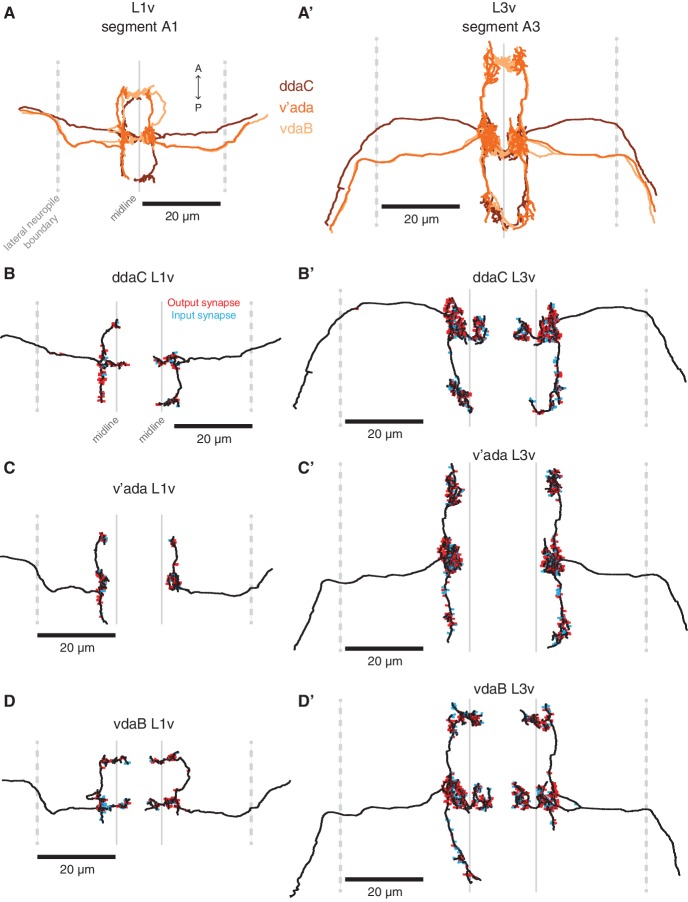
Reconstructions of mdIV terminals.(A, A’), Dorsal view of all mdIV terminals from the L1v (A) and L3v (A’), identities as labeled. Views are at the same scale. Dashed lines indicate lateral neuropil boundaries, solid line the midline. (B, B’) ddaC terminals in the L1v (B) and L3v (B’), left and right shown separately for clarity, as in all subsequent panels. ddaC can be distinguished by a midline crossing where the axon initially approaches the midline from the nerve and a projection into the adjacent segment posterior with little to no midline crossing. (C, C’), v’ada terminals in the L1v (C) and L3v (C’) can be distinguished by a lack of midline crossings and a projection into the adjacent segments anterior and, typically, posterior. D, D’, vdaB terminals in the L1v (D) and L3v (D’) can be distinguished by a midline crossing both where the axon initially approaches the midline and a second midline crossing in the adjacent segment anterior. Note that for all mdIV types, there is some variability — extra or missing branches, such as the missing posterior branch of the right L1v v’ada, are true reflections of the data — although certain features remain typical across most cell types.